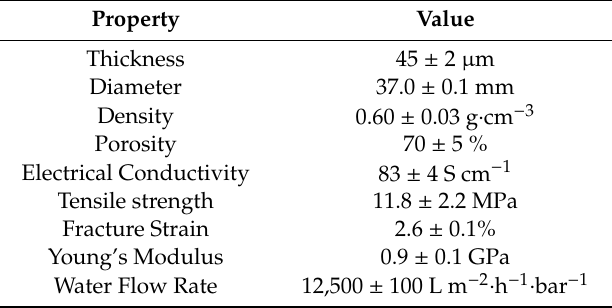
Table 1. Physical-chemical properties of